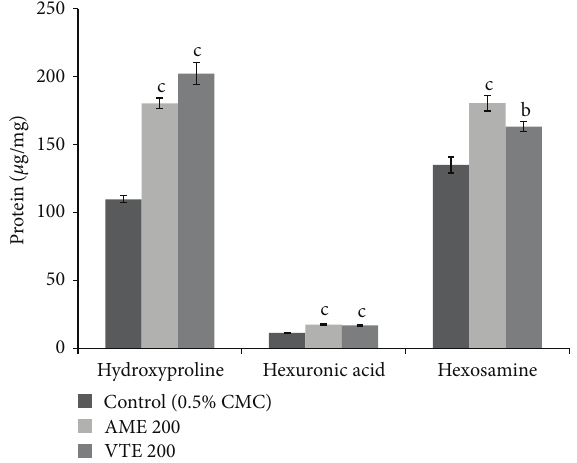
Figure 4: Effect of AME and VTE on dry granulation tissue hydroxyproline, hexosamine, and hexuronic acid content. Results are mean ± SEM ( 𝑛 = 6 ). a 𝑃 < 0.05 , b 𝑃 < 0.01, and c 𝑃 < 0.001 compared to respective control group (statistical analysis was done by one way analysis of variance followed by Dunnett’s test for multiple